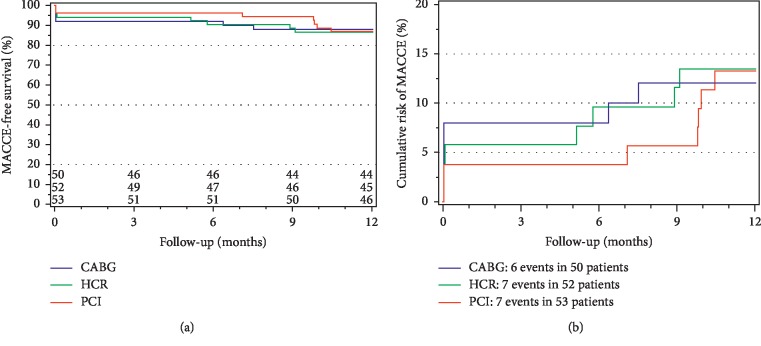
MACCE-free survival (a) and cumulative risk of MACCE (b) during 12-month follow-up according to the treatment arm. Panel A shows MACCE-free survival, whereas the cumulative risk of MACCE is depicted in Panel B. Numbers of patients at risk are shown above the horizontal axis in panel A. Pairwise comparisons of treatment arms with Cox proportional hazards model are shown at the bottom of panel B. MACCE—Major Adverse Cardiac or Cerebral Event.